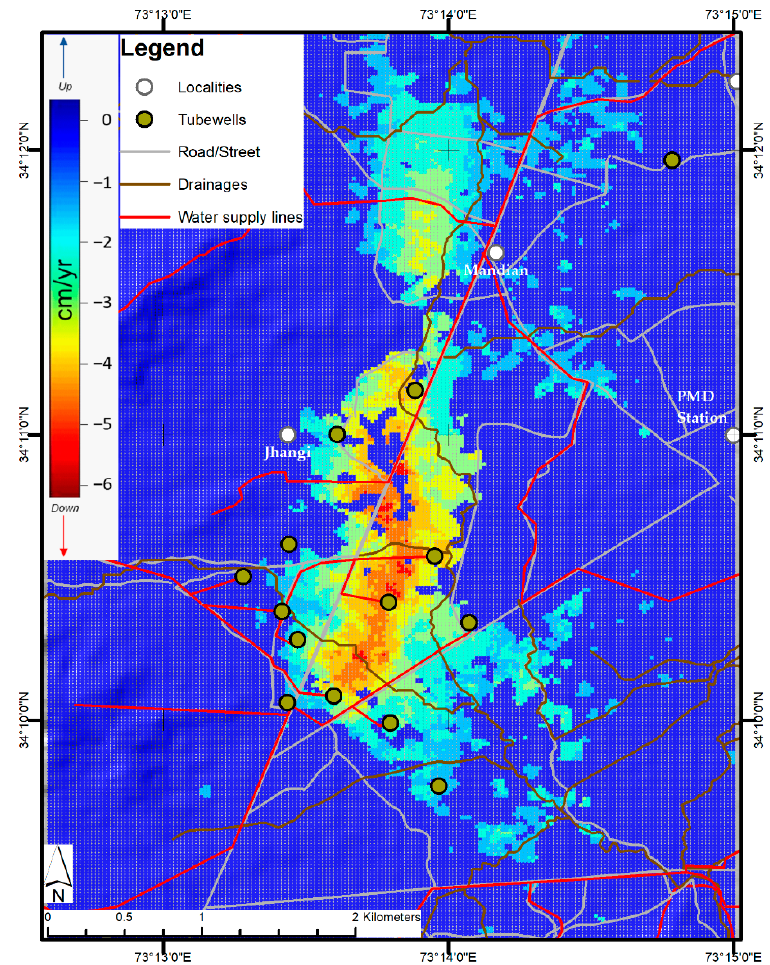
Figure 11. Location of tubewells and supply lines overlaid on average vertical velocity map.